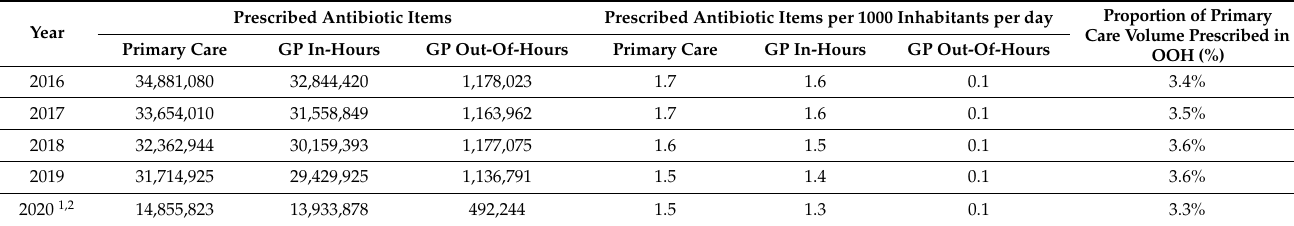
Table 1. Antibiotic items prescribed in different settings.